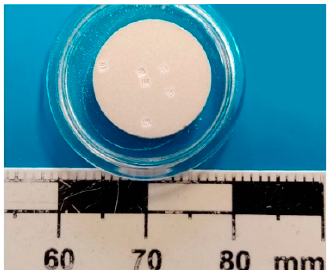
Figure 4. Spodumene pressed pellet used for the LIBS calibration.